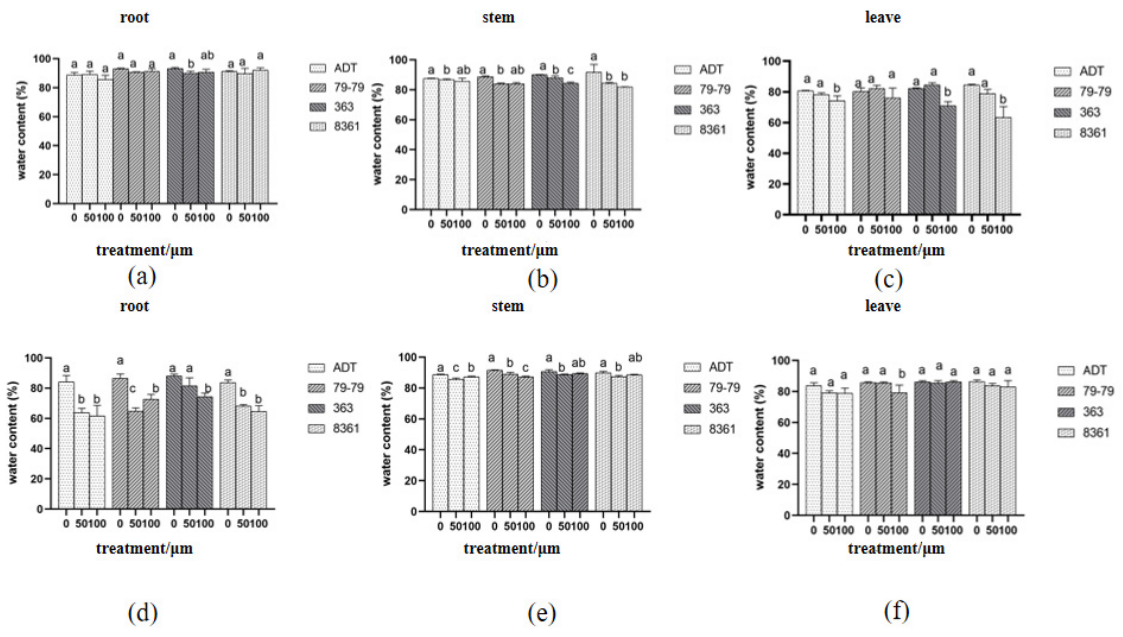
Figure 6. Changes in the water content in the roots, stems, and leaves treated with cadmium for 10 days ( a – c ), 15 days ( d – f ). Within each sunflower variety, the different letters indicate a significant difference at the p < 0.05 level, according to Duncan’s multiple range test.